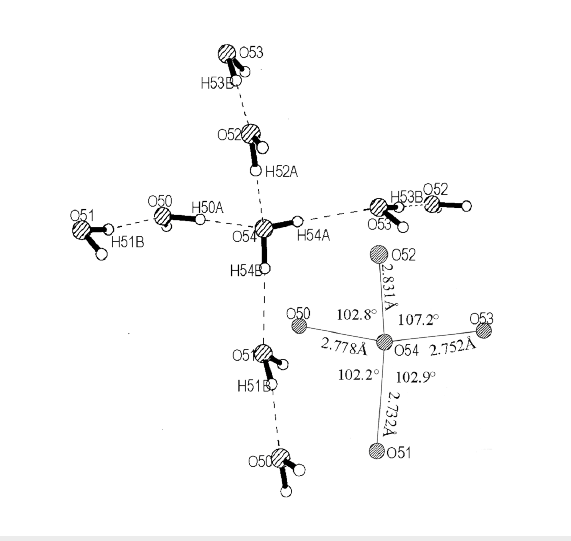
Figure 10: A tetrahedron pentamer of water. The O...O distances and H-O-H angles are indicated in the inset.